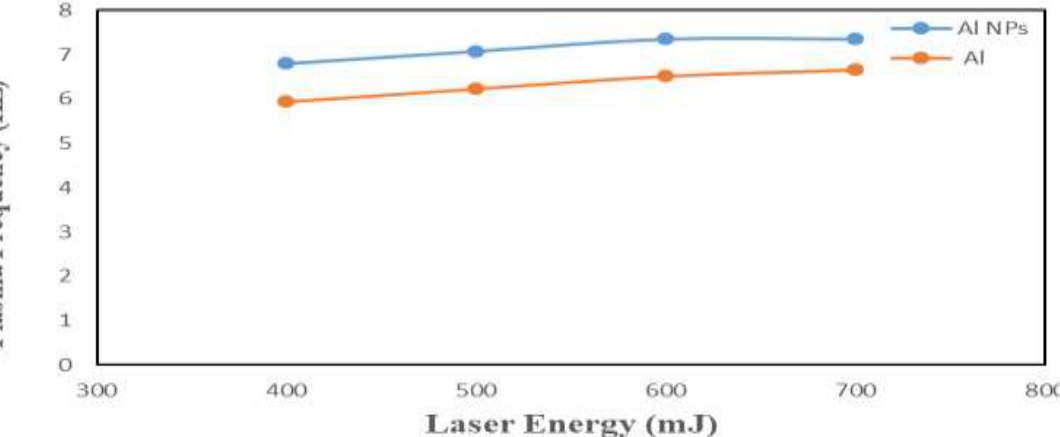
Figure 9: The variation of plasma frequency with laser energy for Al bulk and Al NPs plasma at the atmospheric